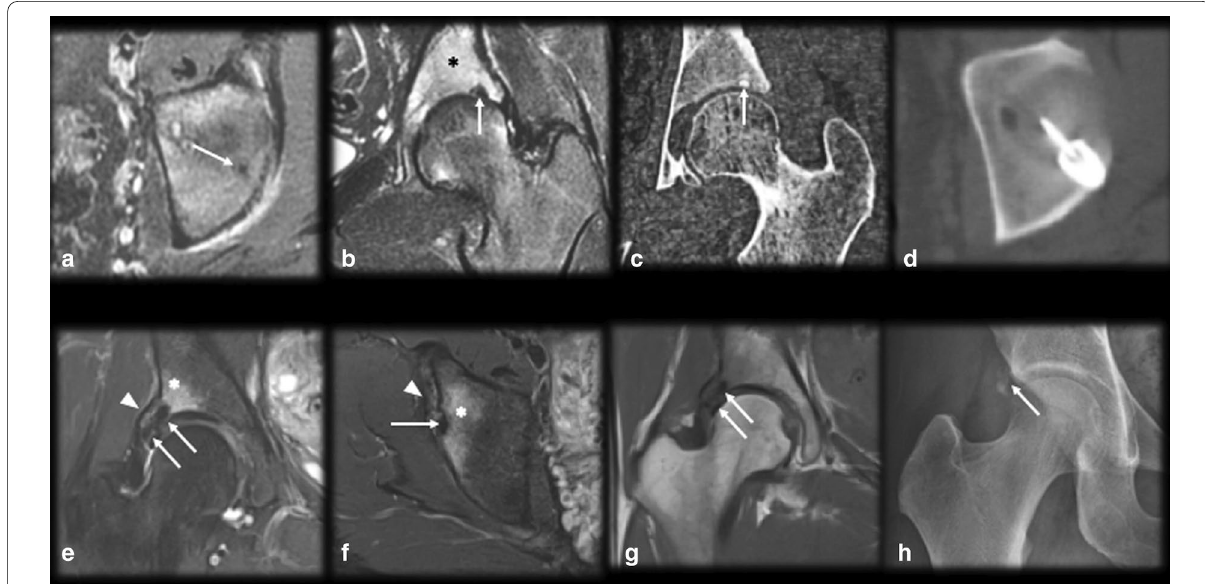
Fig. 12 Osteoid osteoma versus crystal deposition disease. ( a – d ) Male, 19 years old, presenting with groin pain for one year. Axial ( a ) and coronal ( b ) T2 FS MRI and CT ( c ) showed a small mineralized nidus (arrows) and reactional bone marrow edema (black asterisk). Percutaneous CT-guided drill excision was performed ( d ). ( e–h ) Female, 36 years old, presenting with hip pain for 5 months. Coronal ( e ) and axial ( f ) T2 FS and coronal T1 ( g ) MRI showed calcifications (arrows) close to the indirect head of rectus femoris (arrowheads), which were better characterized on the plain radiograph ( h ), with reactional bone marrow edema (asterisk)